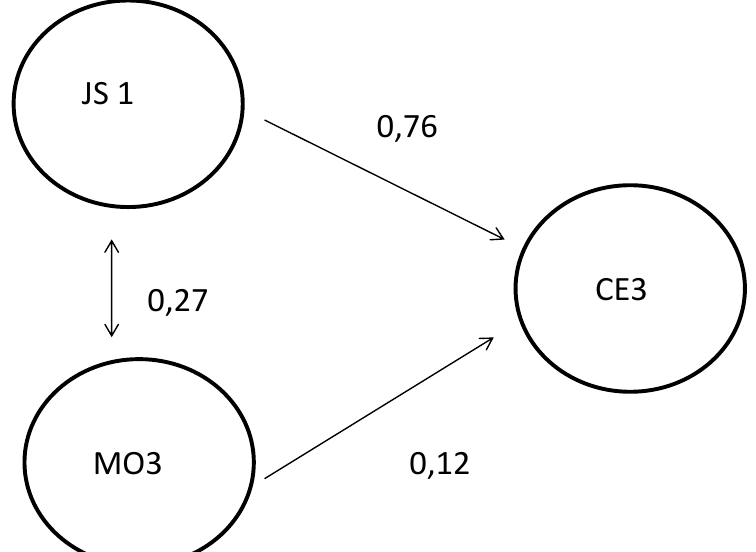
Figure 4: Structural equations model with the corporate entrepreneurship sub-scale of rewards/reinforcement as outcome variable.